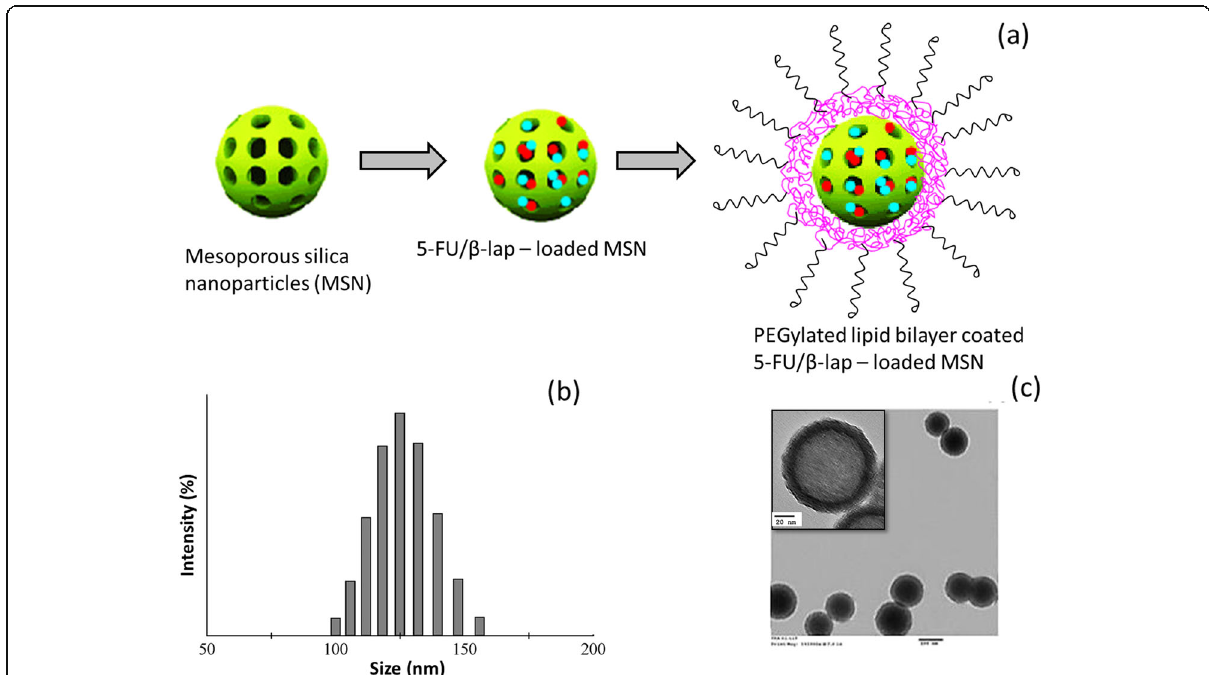
Fig. 1 a Schematic presentation of the construction of 5-FU and ß-lap-loaded lipid bilayer – coated mesoporous silica nanoparticles. Two drugs are loaded in the pores of the MSN which were further stabilized by the PEGylated lipid bilayer assembly on the outer surface of MSN. b Particle size distribution of FNQ-MSN. c TEM image of FNQ-MSN with a inset of higher magnifications